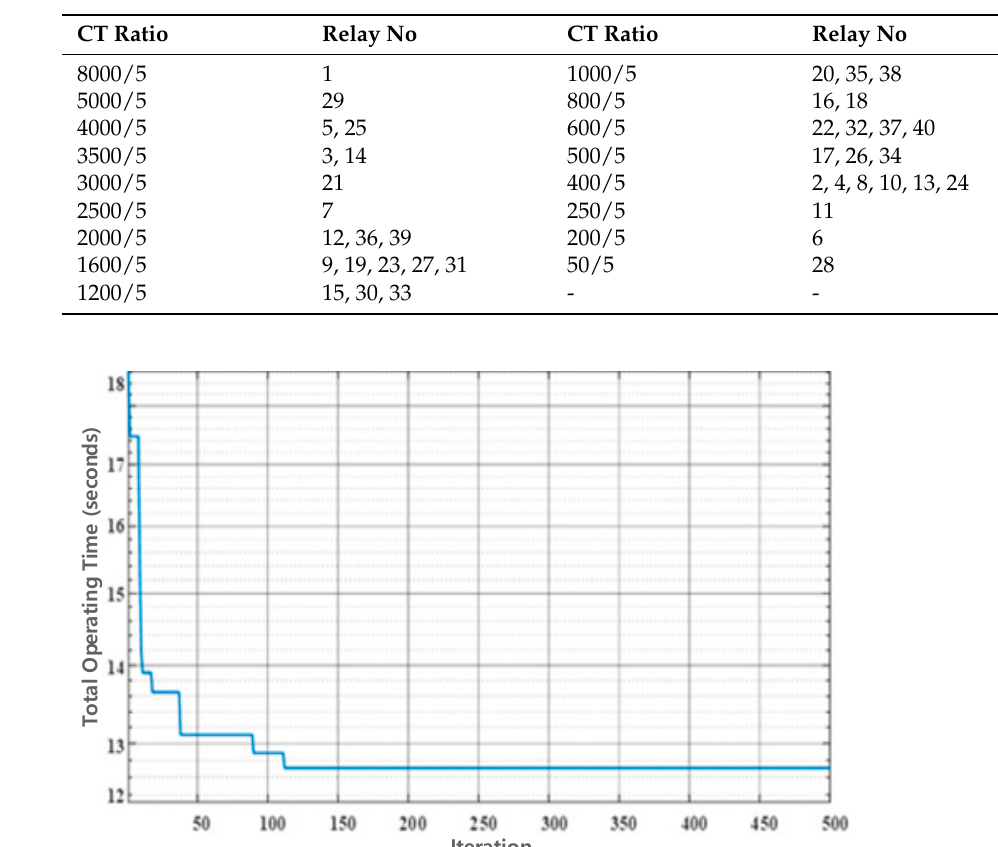
Figure 11. Single line diagram of the IEEE 14 bus system. Table 7. Current transfer ration.